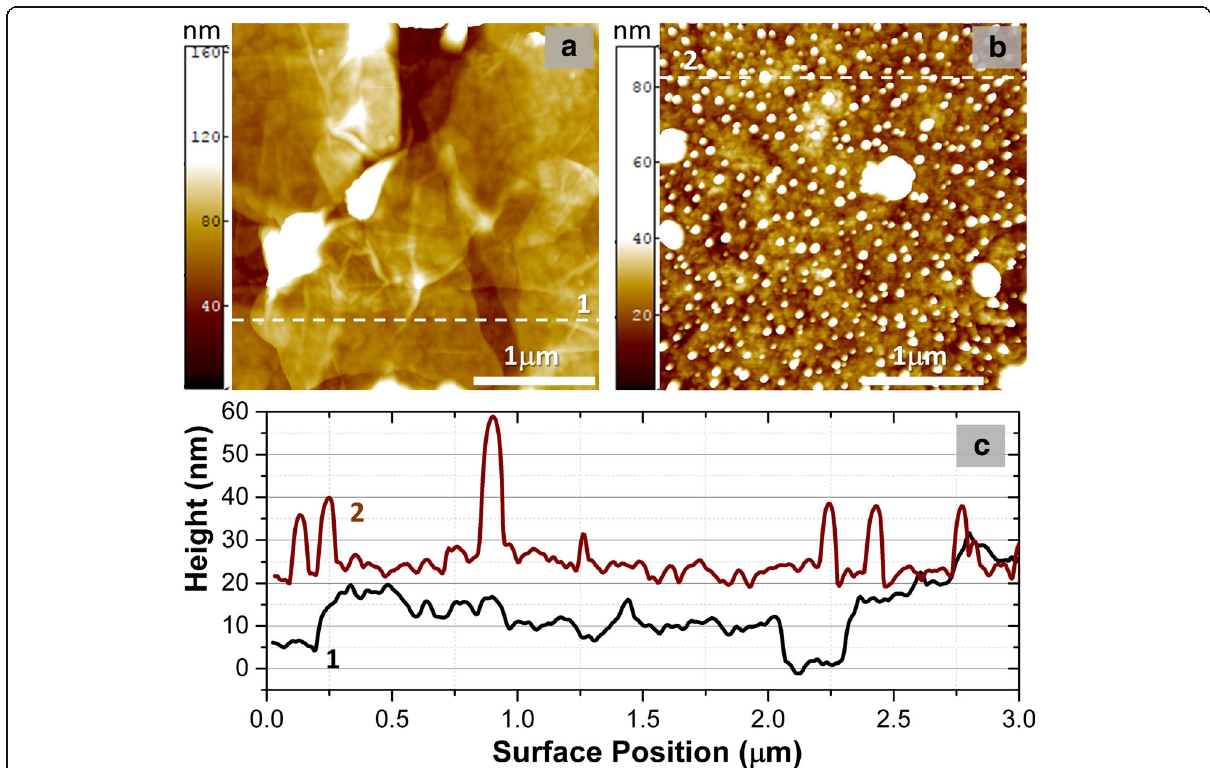
Fig. 6 AFM images of drop-casted GO multiflake structures: fragment of clear GO flakes annealed at 110 °C for 15 min ( a ) and fragment of contaminated GO flakes annealed at 180 °C for 15 min ( b ). Corresponding surface height profiles along dashed lines are shown in ( c